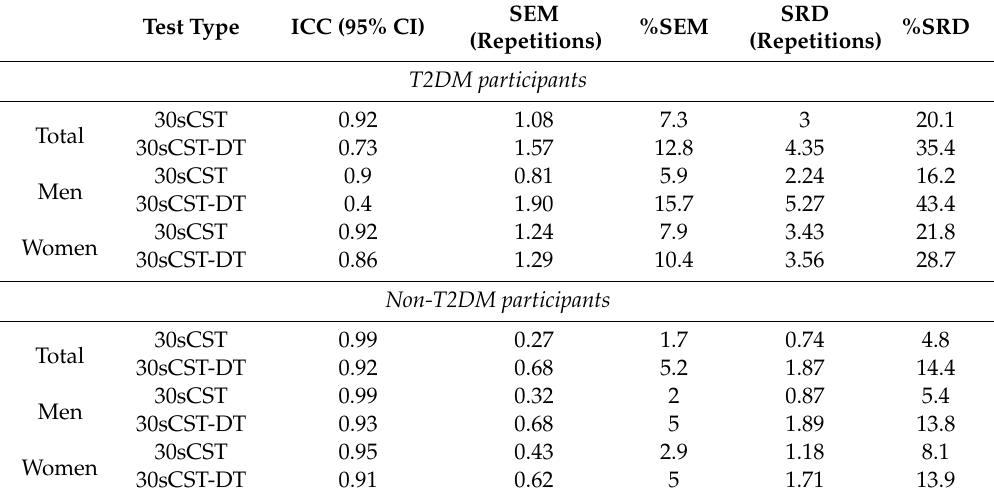
Table 3. Repetitions in the 30-s chair stand test and 30-s chair stand test with the dual-task test in the two measurements (test–retest) taken 7–14 days